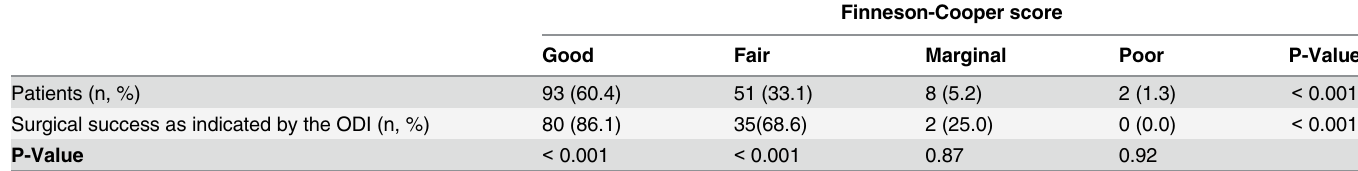
Table 5. The surgical success based on ODI by Finneson – Cooper